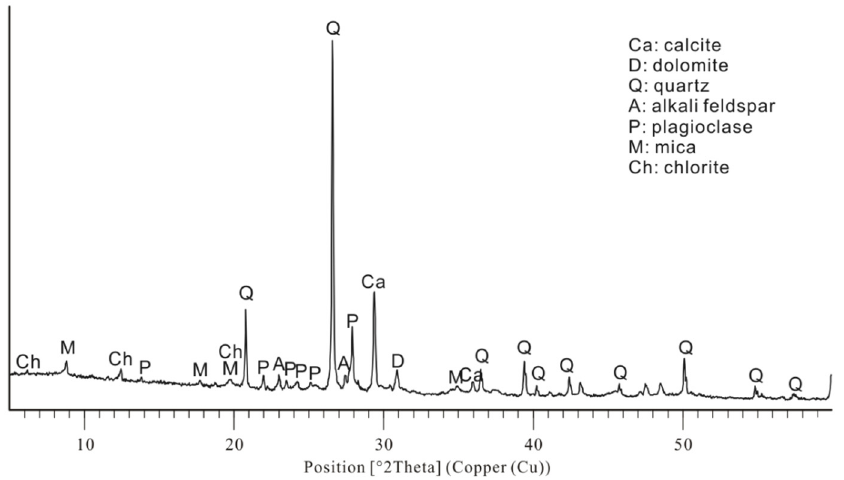
Figure 5. X-ray diffraction patterns of residual soil.